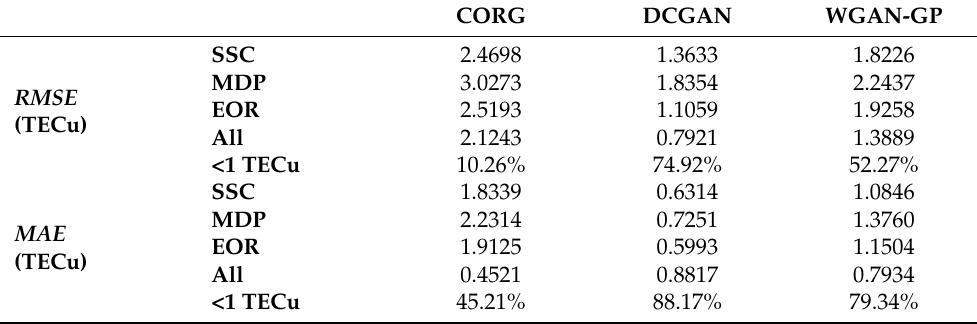
Table 4. RMSE and MAE performance during geomagnetic storm in February 2014.